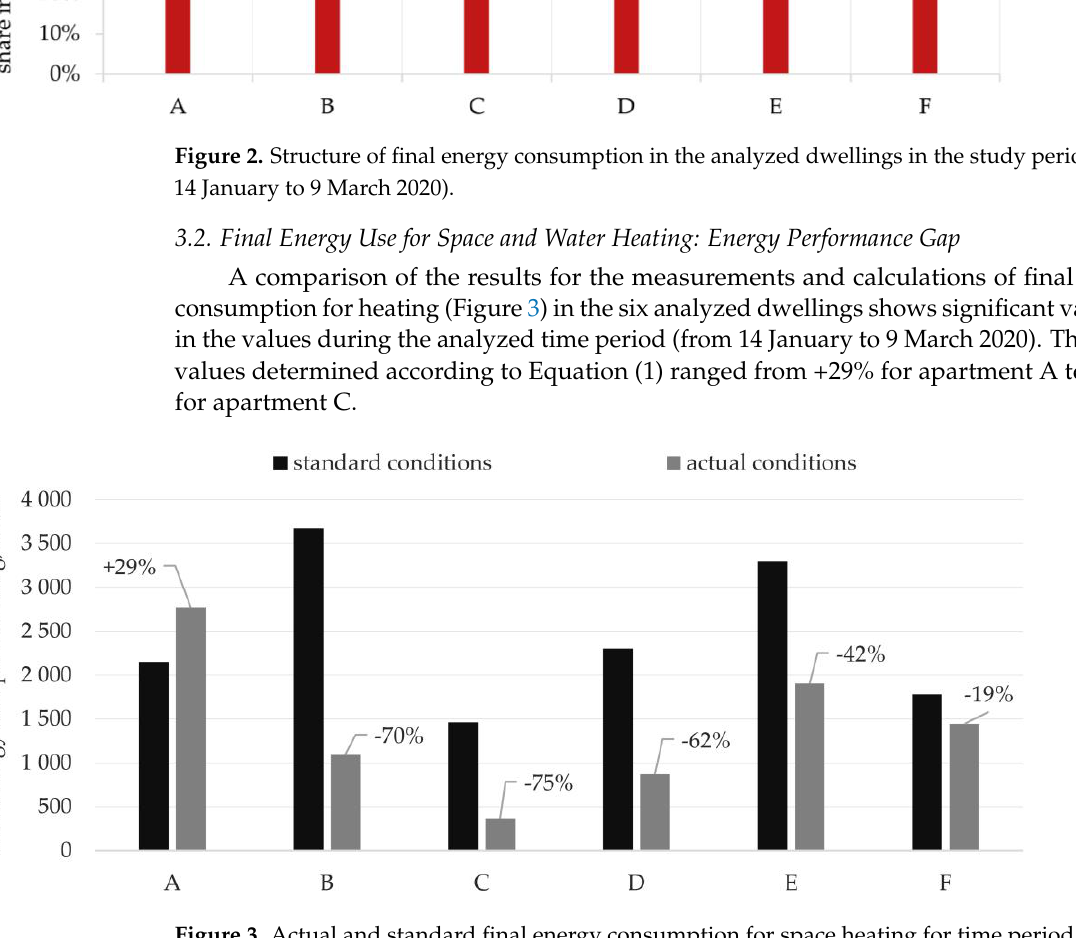
Figure 2. Structure of final energy consumption in the analyzed dwellings in the study period (from